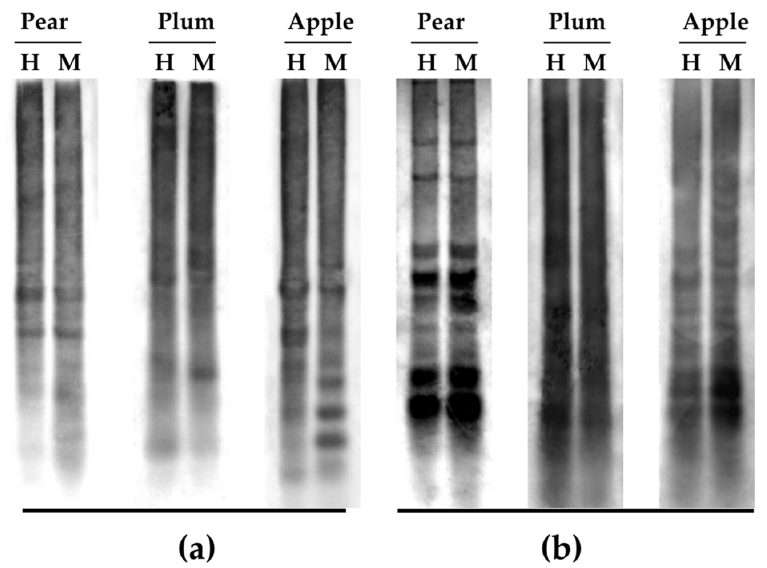
Figure 4. Gel blotting analysis of DNA methylation at the 5′-CCGG sites in the three fruit tree cultivars using as probes the copia -like ( a ) and gipsy-like ( b ) mixtures amplified by PCR using degenerate primers that target the reverse transcriptase (RT) region of each of the two major TE families. Each DNA sample was digested with HpaII (H) and MspI (M), and the two digests were loaded on the gel side by side. The overall smearing feature and the alikeness between digests by the pair of isoschizomers indicates the overall low methylation levels at the 5′-CCGG sites of both TE families.